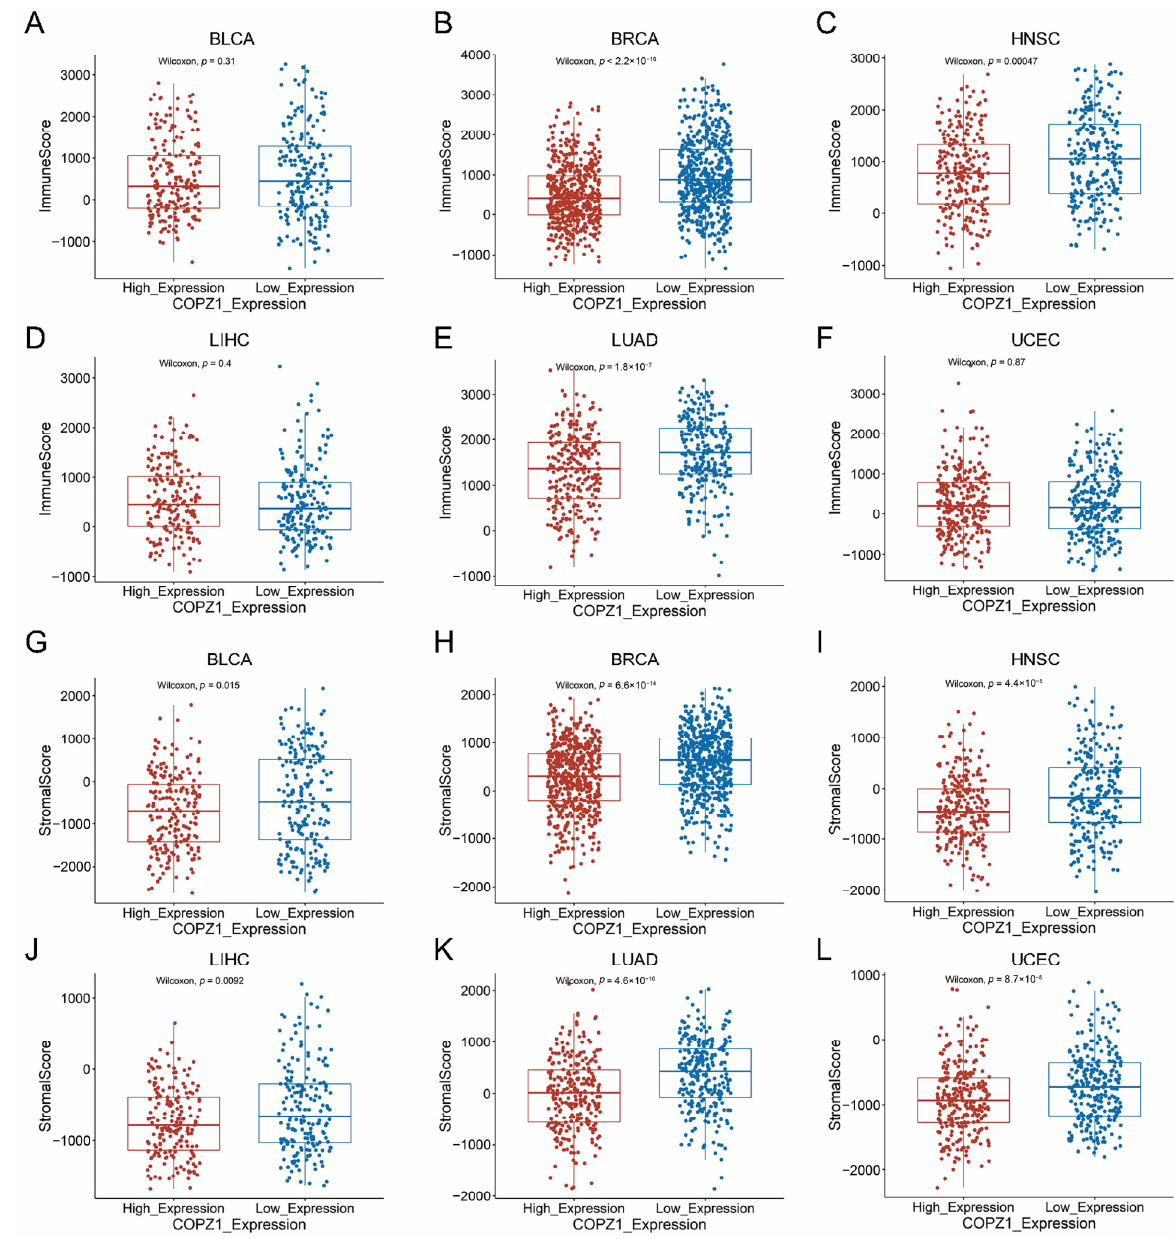
Figure 7. The correlation between COPZ1 expression and immune score and stromal score. ( A – F ) The immune score between high and low COPZ1 expression groups in multiple cancers. ( G – L ) The stromal score between high and low COPZ1 expression groups in multiple cancers. The red box means high COPZ1 expression group, and the blue box means low COPZ1 expression group.